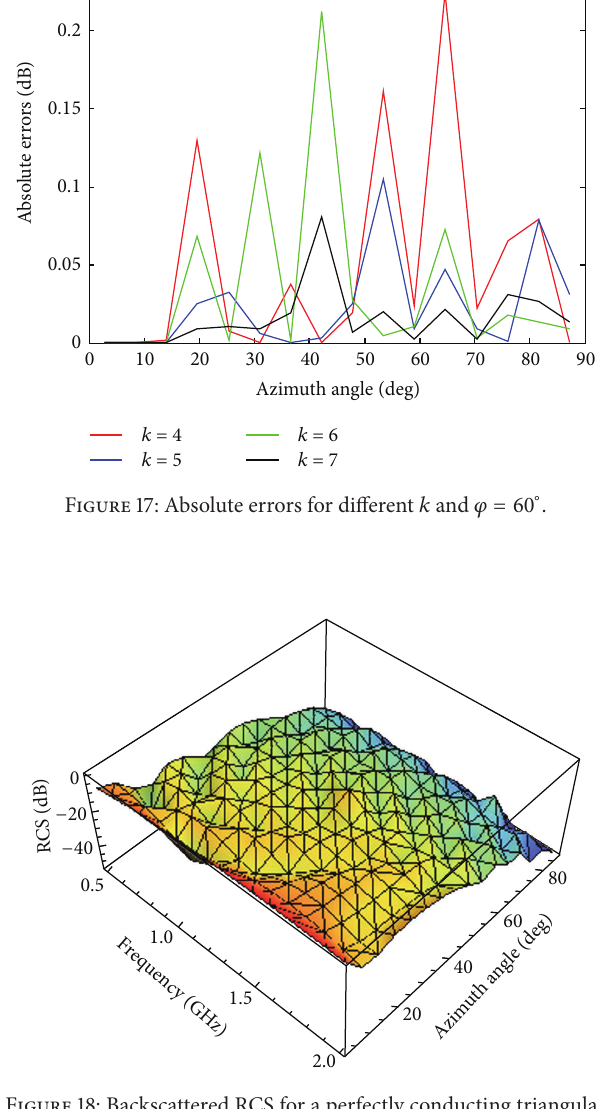
Figure 18: Backscattered RCS for a perfectly conducting triangular flat plate for 𝜃 and frequency of ̂𝑚 = 16.